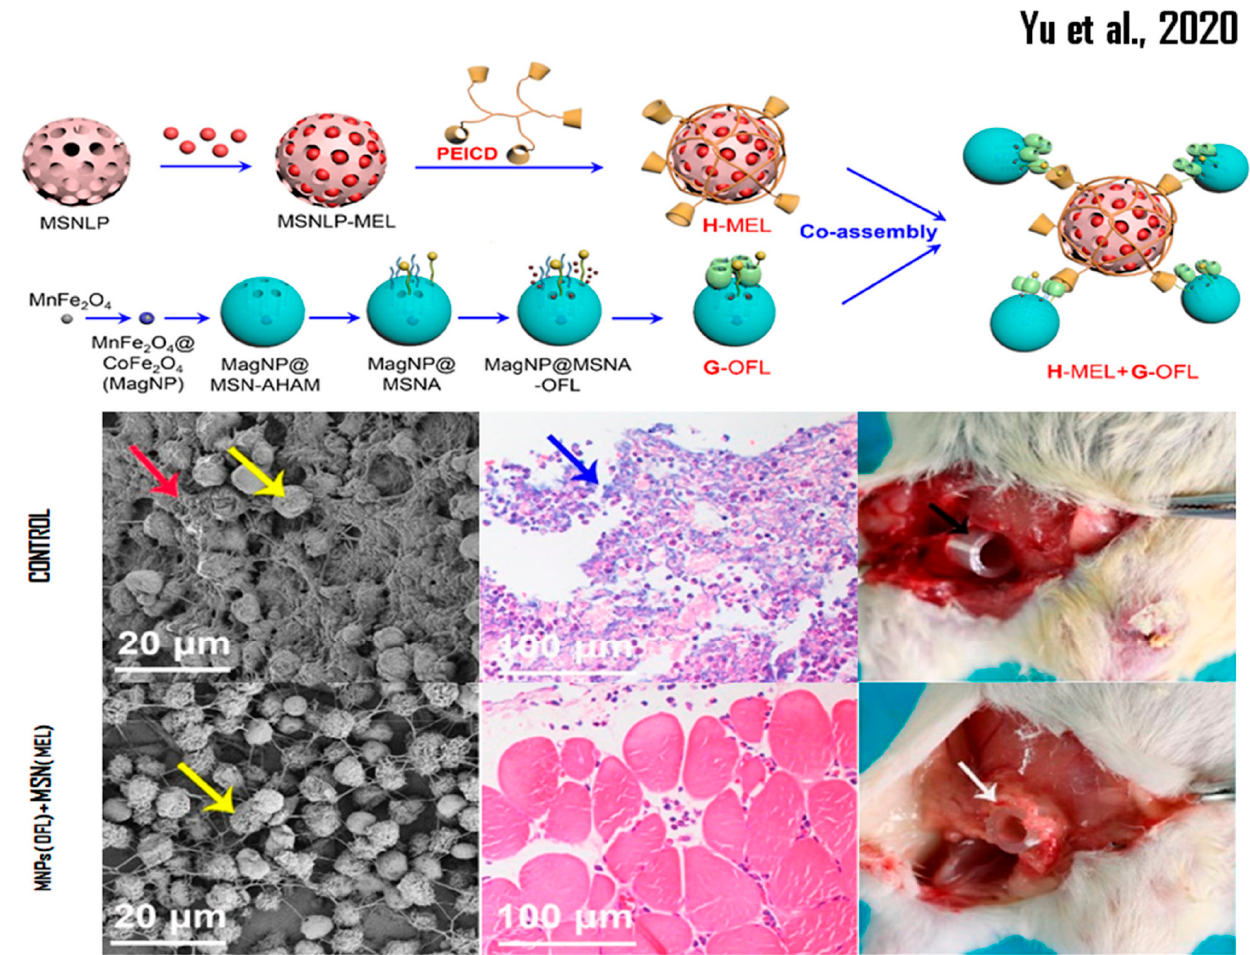
Figure 1. Representation of bioconjugated MSN nanosystems and their effectiveness in in vivo studies. Reprinted/adapted with permission from Yu et al. [152]. Copyright 2020, ACS Chemical Society.